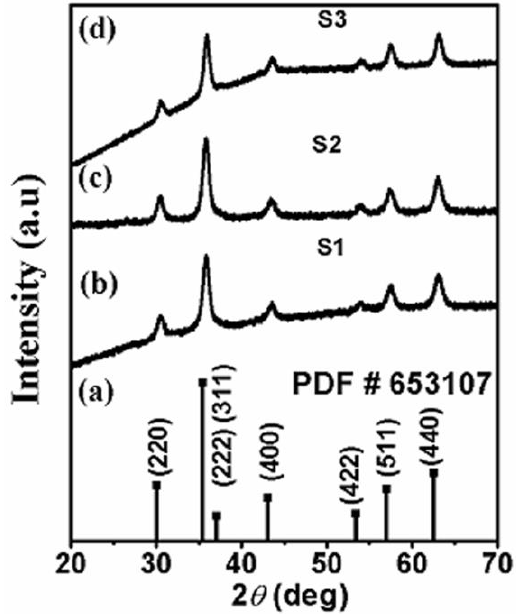
Figure 1. ( a ) The JCPDS data and the X-Ray diffraction (XRD) patterns of Fe 3 O 4 –γ -Fe 2 O 3 core – shell nanoparticles for samples ( b ) S1; ( c ) S2; and ( d )